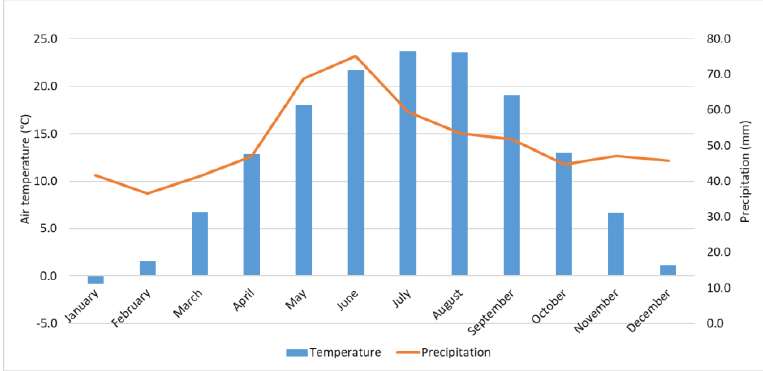
Figure 2. Average monthly air temperature and precipitation amounts at Bucharest (1961–2018).